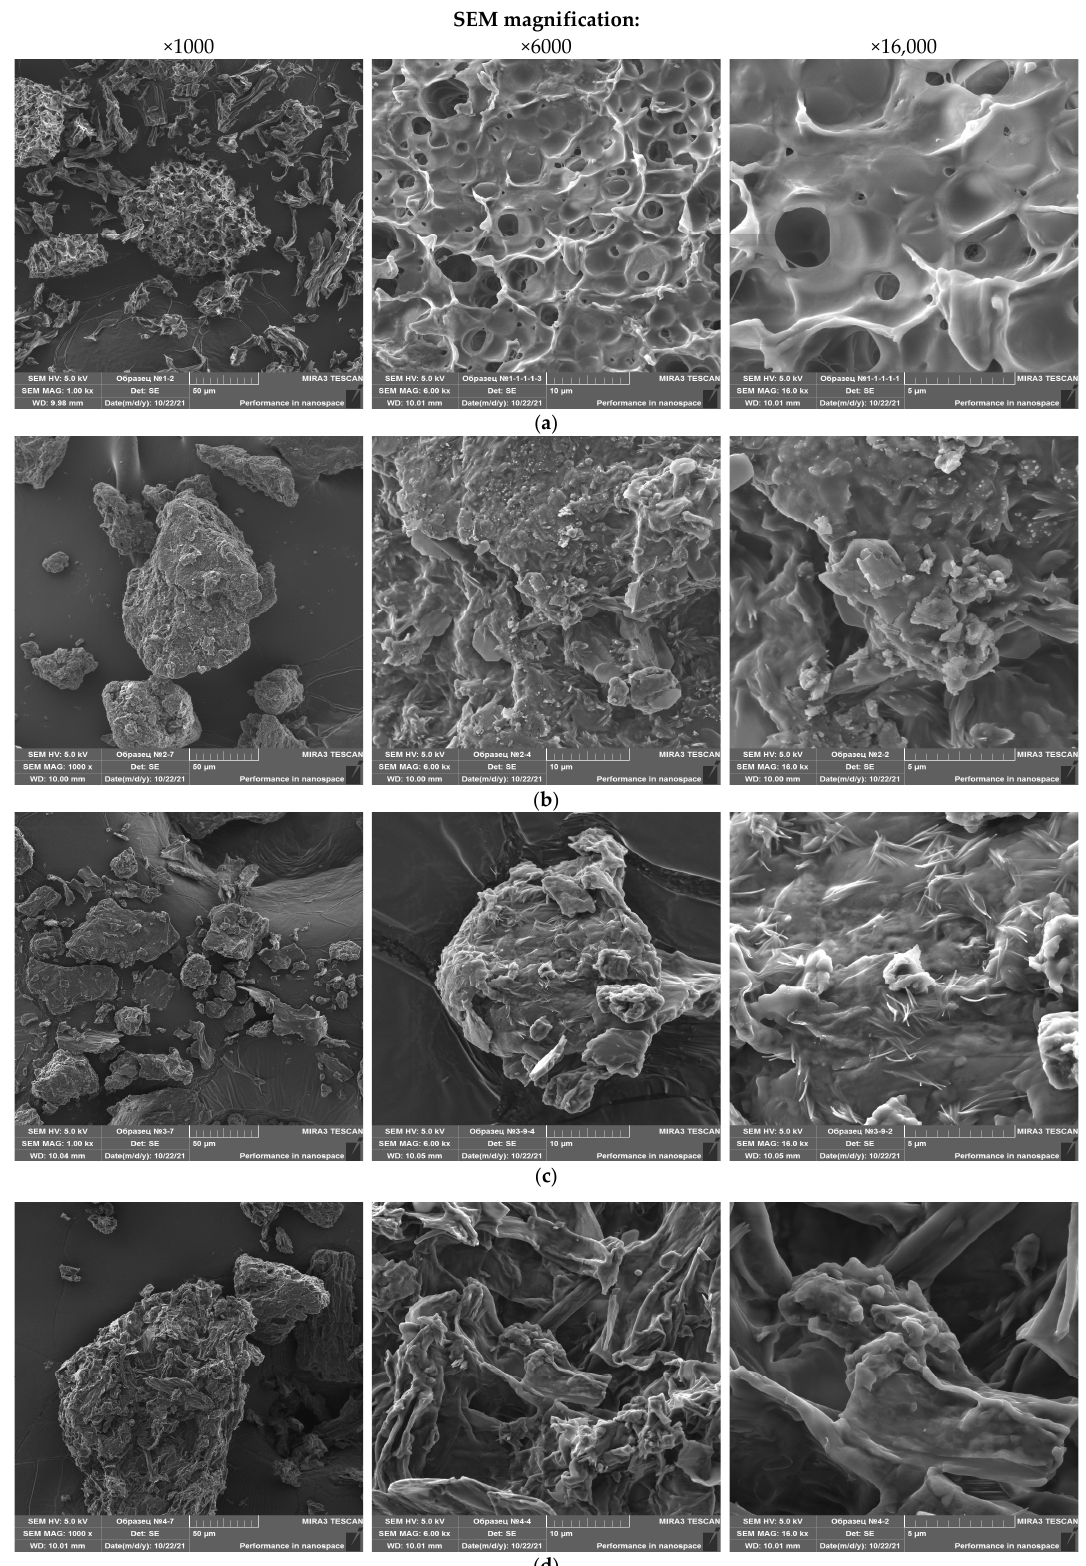
Figure 4. Scanning electron microscopy images of mushroom powders obtained by different drying methods: ( a ) FD; ( b ) HAD; ( с ) MWD; ( d ) SD. The surface microstructure of the FD sample particles differed significantly from the structure of other powders. Ice sublimation of cells in the FD method occurs slowly, which significantly affects the structural properties of the cells, even when the lyophilized mate- rial is crushed into powder [55]. The FD sample exhibited irregular morphology, with flake-like particles and a highly porous structure, probably formed during the formation of ice crystals at the freezing stage and characterized by Vardanega, R. et al. [3] as a typical structure for sublimates. In some places, the ice formation bound the cells together and made it difficult to distinguish them. Similar porous structures were observed by Taskin, O. et al. [56] and Ouaabou, R. et al. [51] when freeze-dried fruits were powdered. The particles of the HAD sample were densely arranged and had flattened cellular structures, probably associated with a decrease in cell pressure and collapse of cell walls due to faster moisture removal and high dehydration rate. Morphologically, the surface of the HAD powder mainly had a lamellar structure (scaly shape) with multiple cracks and other deformations. The mechanical impact of grinding led to the formation of parti- cles with sharp edges on their surface. Similar images were observed for carrot powders prepared using the HAD method in an experiment by Özbek, H.N. et al. [57]. The MWD powder particle samples appeared more compact and were characterized by an uneven surface with significant dents, potholes, and dotted with remnants of de- stroyed cell membranes. The surface of the MWD particles resembled the appearance of fused microaglomerates, probably formed due to cell fusion caused by cell wall damage under microwaves treatment. Similar destruction of the cellular structure was recorded by Isic, N. I. E. and Islam, N. [58] in an experimental search for the optimal model of mi- crowave dehydration of mushroom ( Agaricus bisporus ). Grinding of the SD samples into a powder form led to the formation of amorphous particles with a strongly wrinkled surface, but in contrast to the HAD and MWD samples, with a large preservation of the morphology of the mushroom tissue. Similar structures were observed by Kong, D. et. al. [59] for vegetable and fruit powders obtained using SD. The observed features were probably related to the unavoidable influence of ultraviolet radiation during sun drying, which according to Forouzanfar A. et. al. [60], could reduce the destructive force of temperature and other drying conditions. The presented SEM images proved to be good evidence of structural changes result- ing from drying and subsequent grinding. The maximum destruction of the initial porous structure of the mushroom was observed after the application of the HAD and MWD methods. The particle surfaces of the FD and SD samples were characterized by a lower degree of structural damage, which according to Sadowska A. [61], could provide a higher level of rehydration properties and moisture holding capacity of the powder.